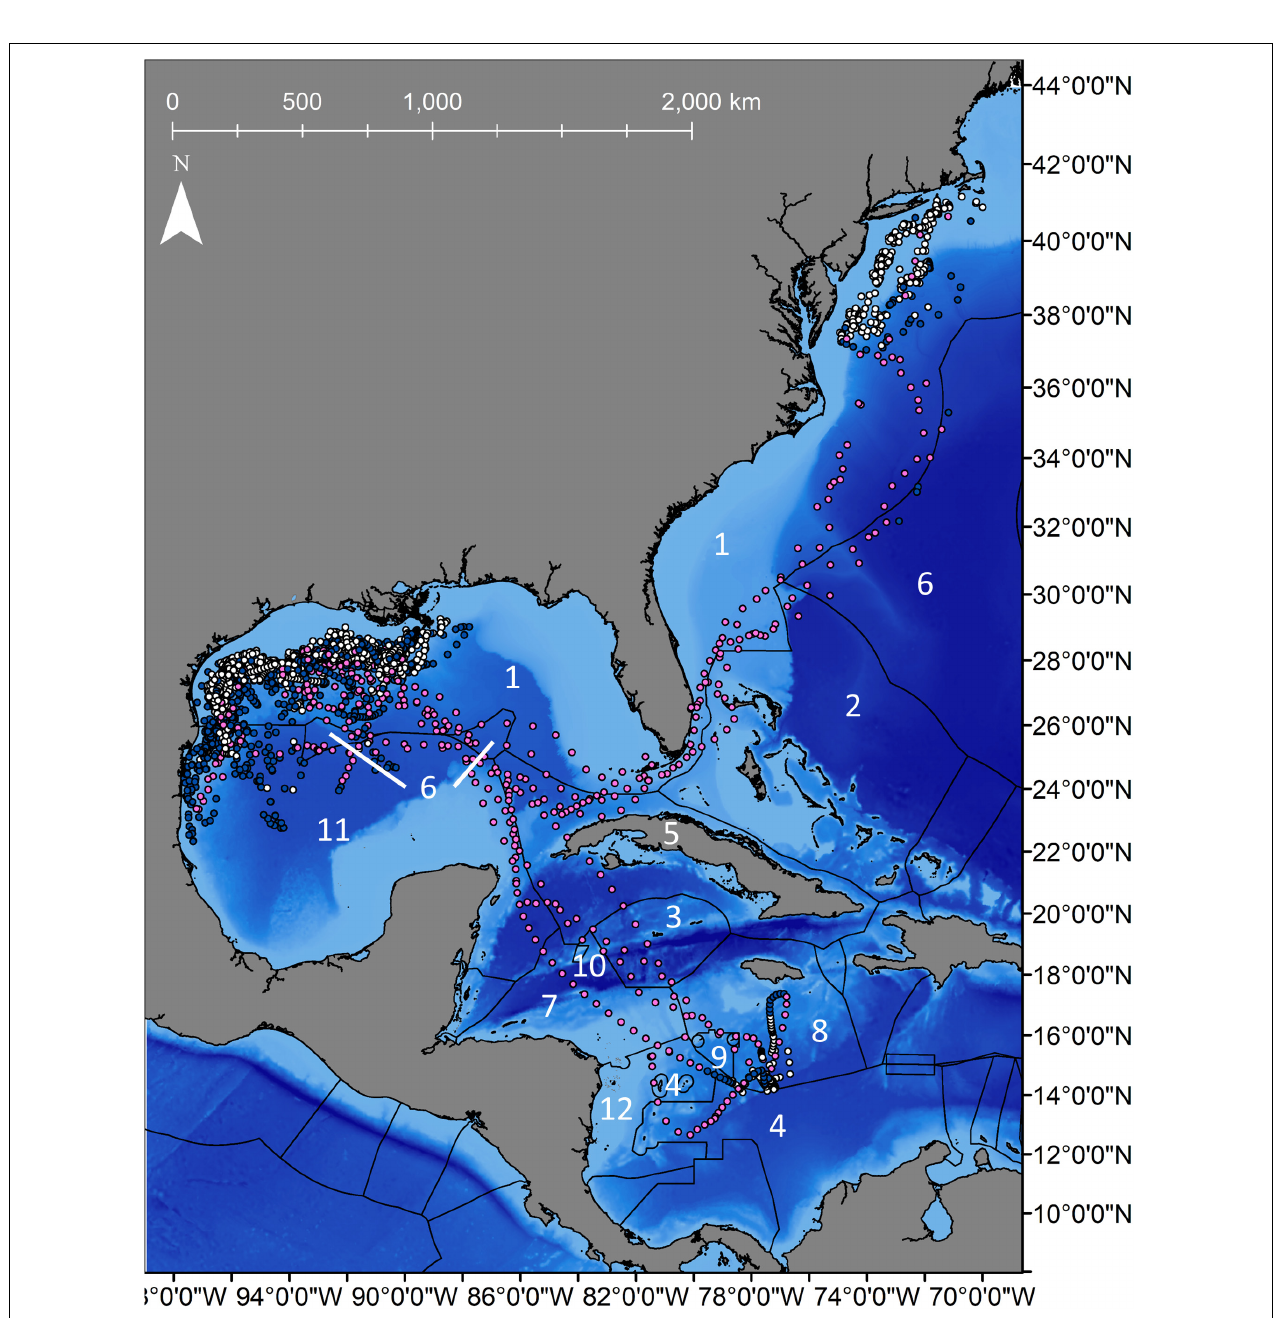
FIGURE 3 | Daily locations for 8 shortfin makos tagged in the northwestern Gulf of Mexico with Exclusive Economic Zones (EEZ) for each country. Navy dots represent resident behavior based on the first-difference correlated random walk switching model, while pink dots represent transiting behavior. Gray dots represent unclassified behavior. EEZs that sharks transited through are represented by numbers that correspond countries listed in Table 2